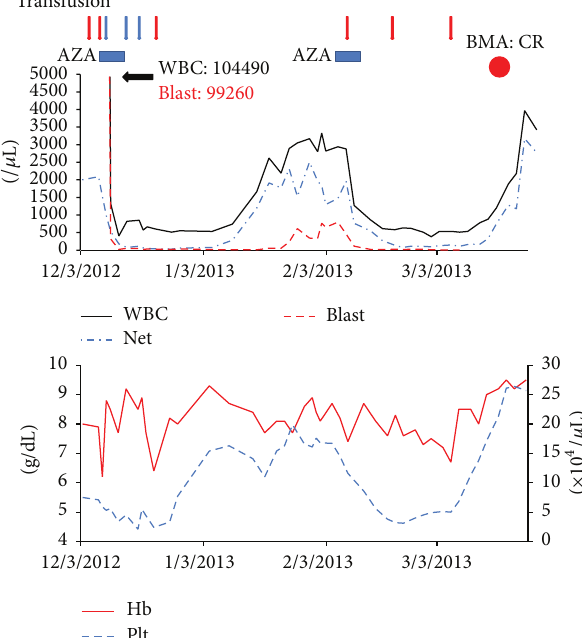
Figure 2: Clinical course after disease